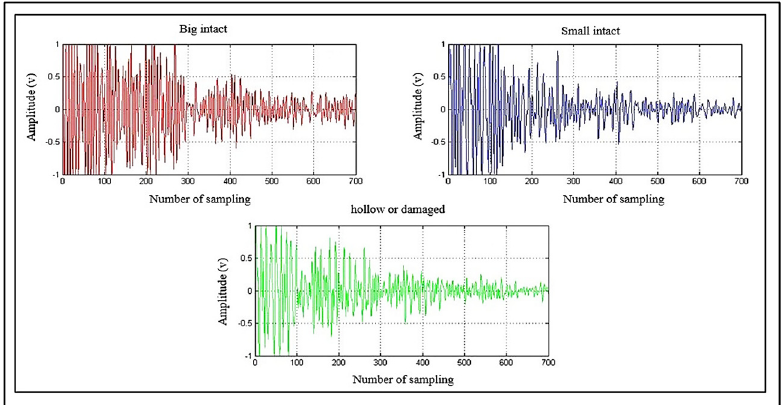
Figure 15. Signal curve of a hazelnut in the time domain.